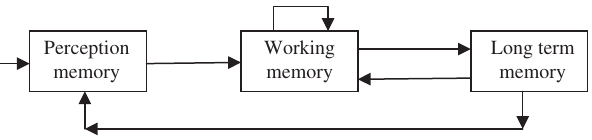
Figure 3. Multistore Human Memory Model (Atkinson and Shiffrin Model